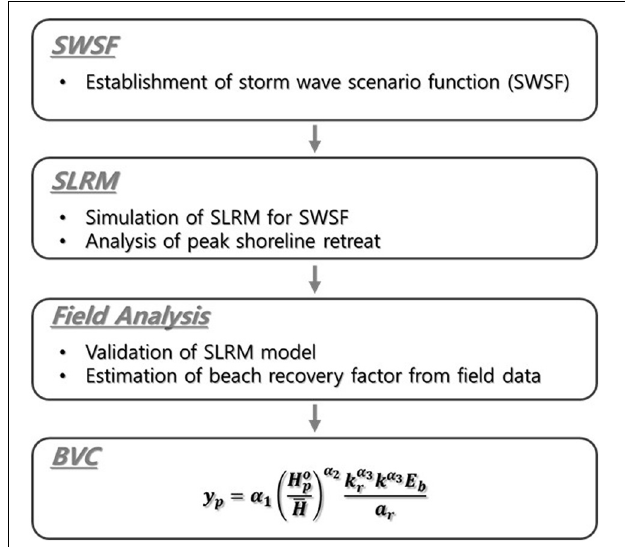
FIGURE 1 | Research processes for deriving a beach vulnerability curve (BVC).